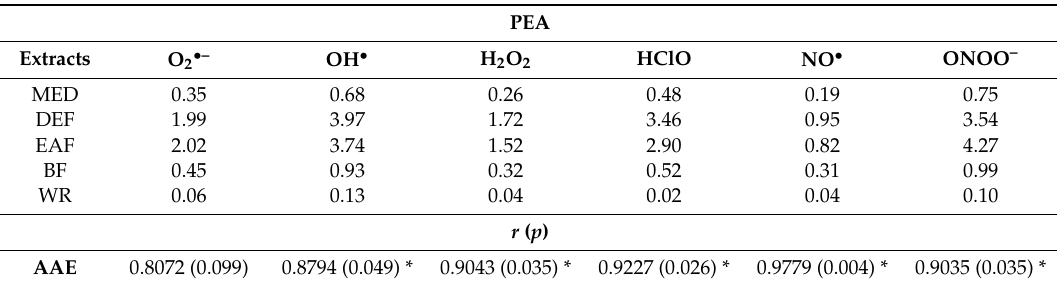
Table 2. Predicted extract activity indices (PEA) values for extracts in particular assays and their correlations with extracts’ activity parameters (AAE).